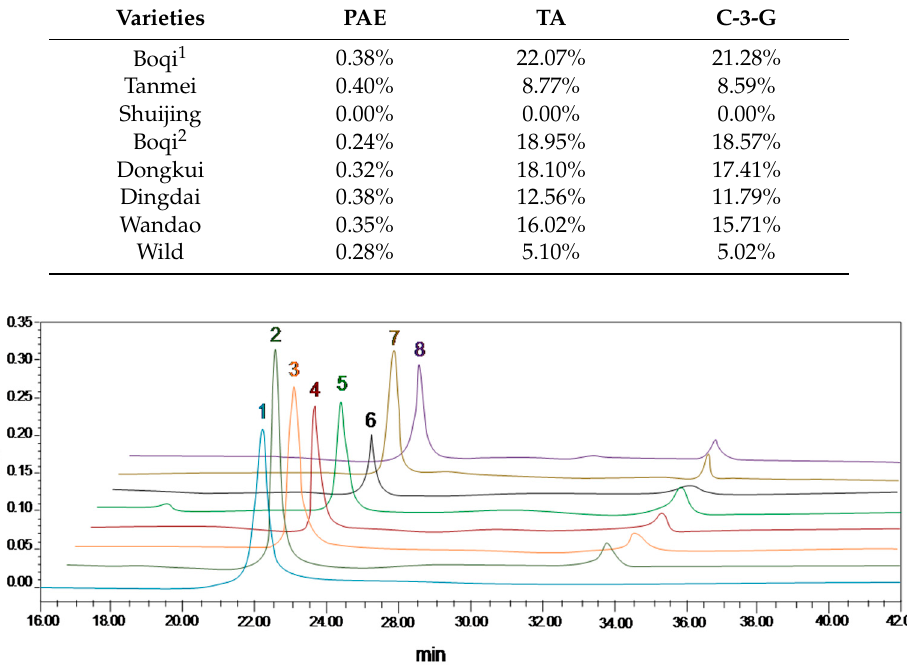
Figure 3. HPLC results for cyanidin-3- O -glucoside (C-3-G) in purified anthocyanin extracts. 1, C-3-G standard; 2, Boqi 1 ; 3, Boqi 2 ; 4, Wandao; 5, Dingdai; 6, Wild; 7, Dongkui; 8, Tanmei. Table 1. The levels of purified anthocyanin extracts (PAEs), and the total anthocyanin (TA) and